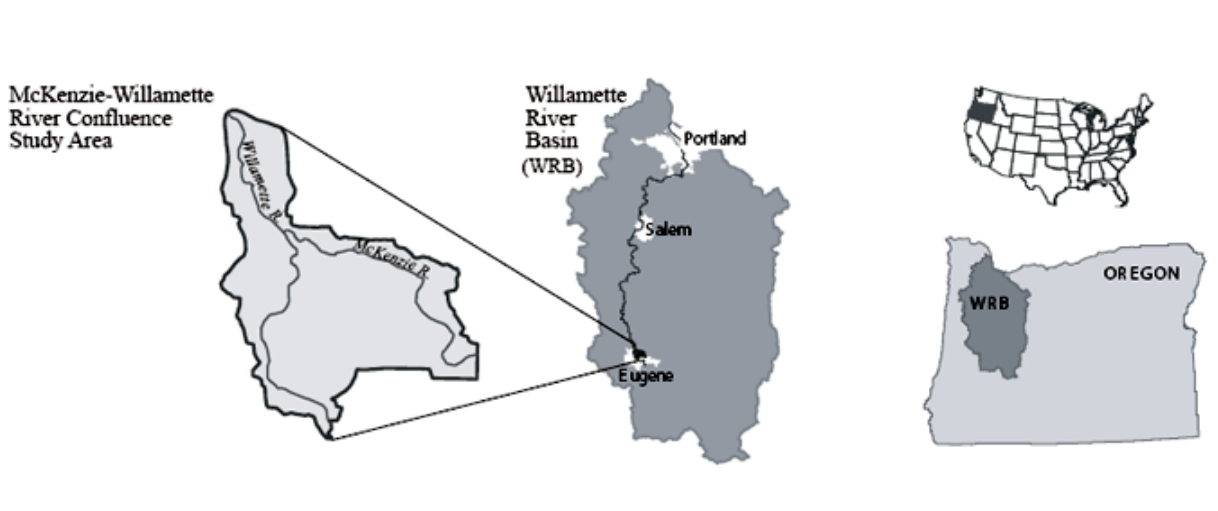
Fig. 2 . Context map for the McKenzie study area. The study area is in Lane County, Oregon, which is in the southern part of the Willamette